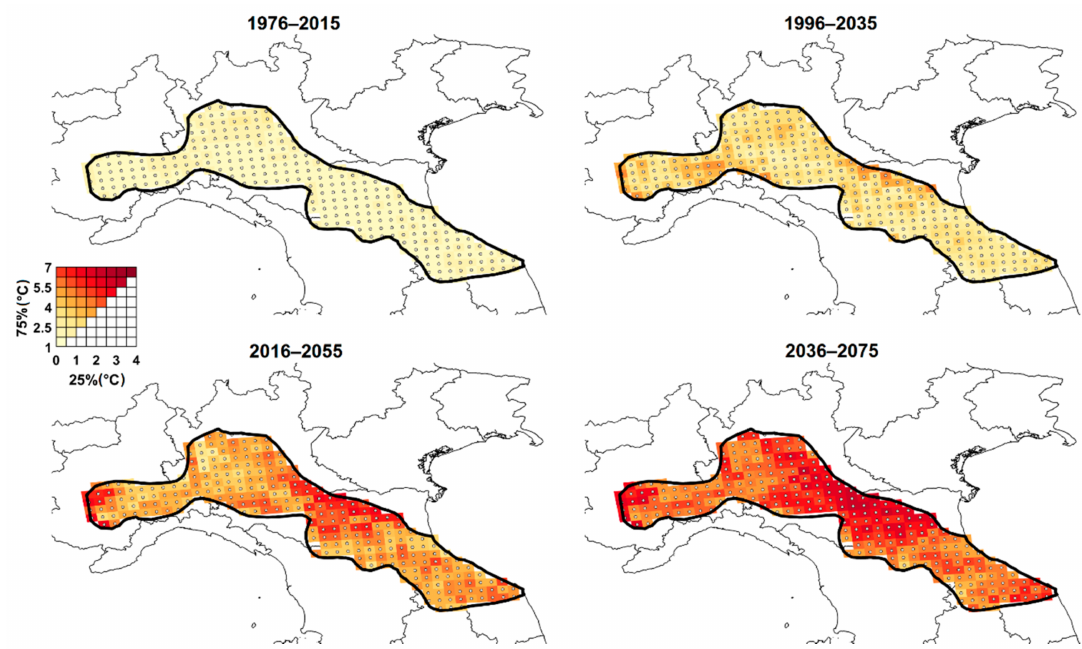
Figure 8. Factors of change for T Min,k in the time windows 1976–2015, 1996–2035, 2016–2055, and 2036–2075 in comparison with the reference time interval 1956–1995—prediction interval (25–75%) map (Scenario RCP4.5).